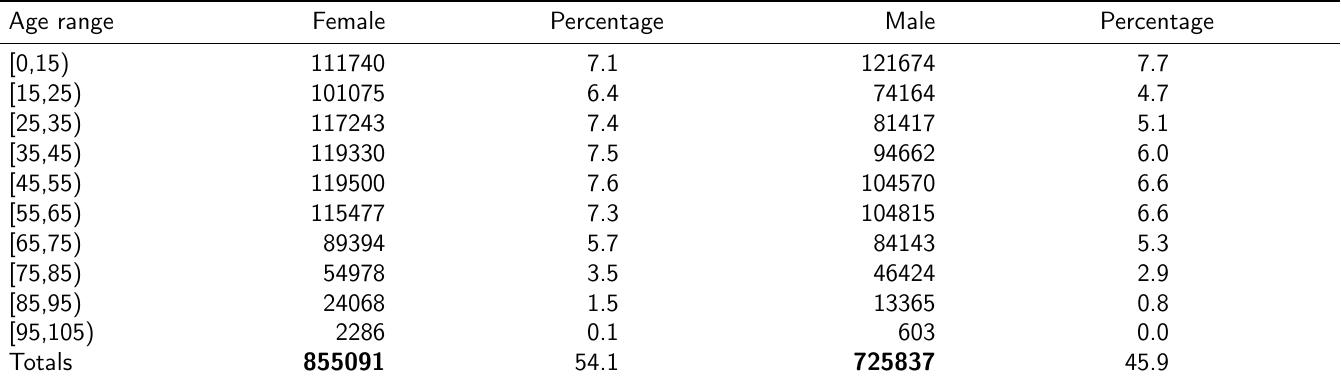
Table 1: The number of PBS data study participants by age grouping and gender